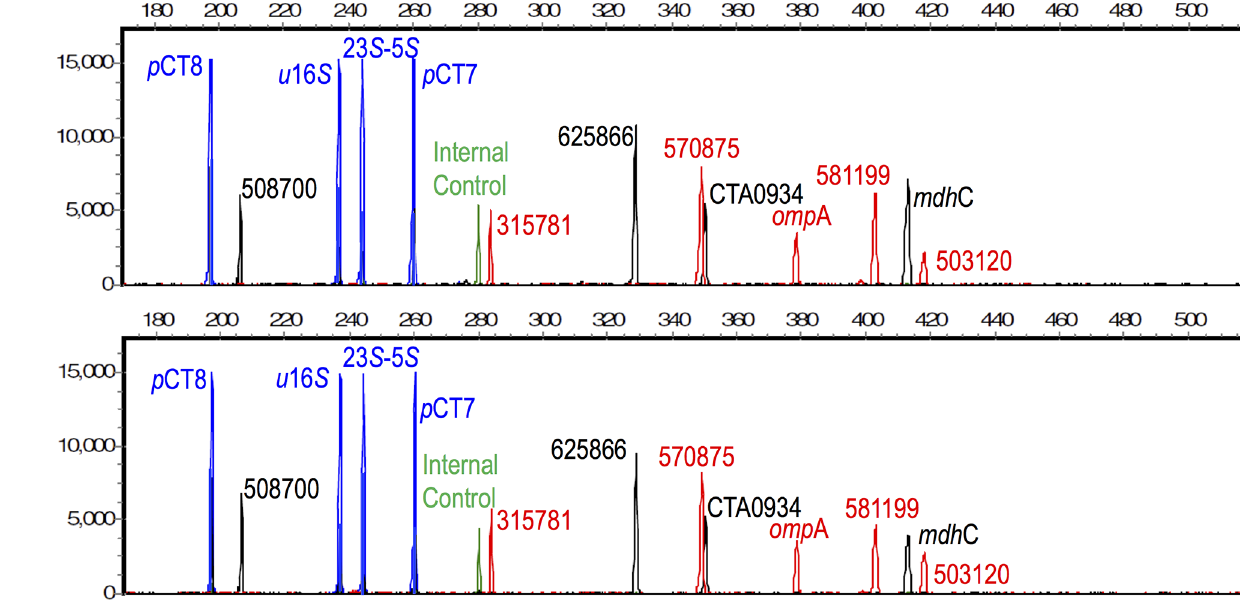
PLOS ONE | https://doi.org/10.1371/journal.pone.0178653 May 31,